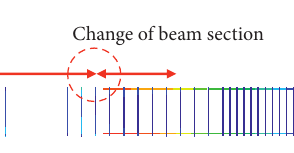
Figure 20: Stress distribution of total model.